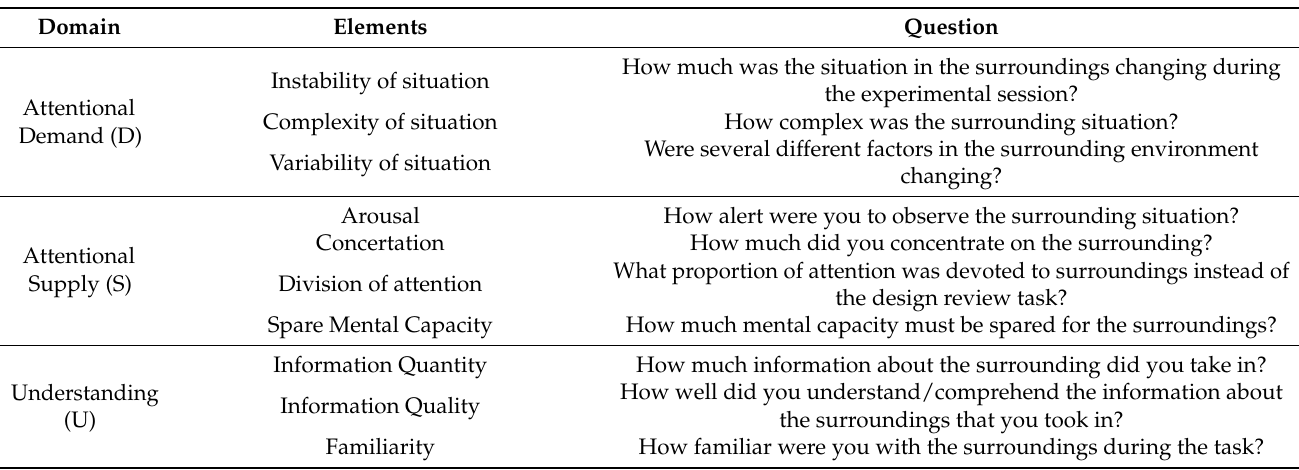
Table 2. Situational awareness rating technique